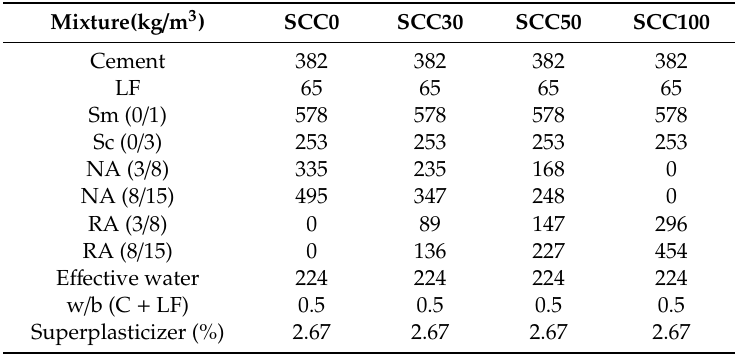
Table 3. Mix composition of the concretes, per cubic